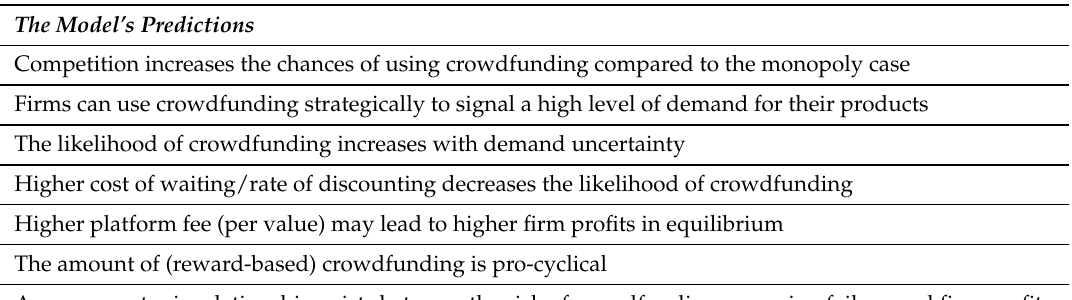
Table 2. The model’s results and testable empirical